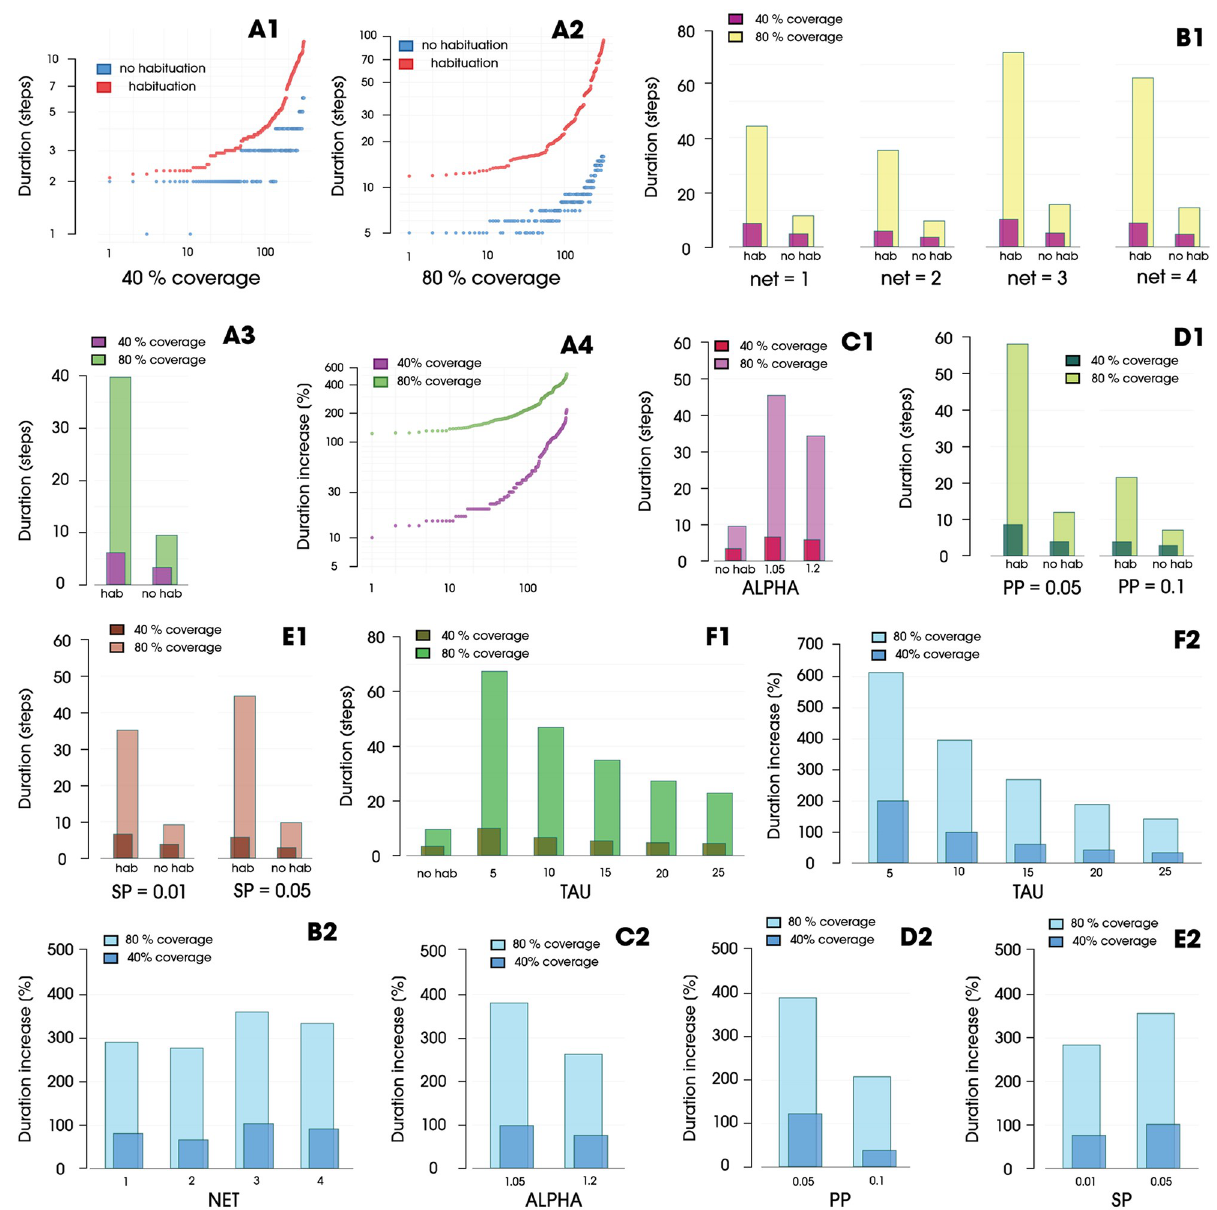
Fig 6. ( A1-A2 ) Distances between the durations of simulations with and without the habituation effect, with results sorted by duration without habituation and assigned corresponding results from processes with habituation. ( A3 ) Duration for spreading processes with and without habituation. ( A4 ) Duration increases in processes with the habituation effect, compared to processes without habituation, sorted by coverage increase. ( B1 ) Durations for each network for spreading processes with and without habituation. ( B2 ) Increases in duration for each network in relation to a process without habituation. ( C1 ) Durations for each alpha value for spreading processes with habituation compared to a process without habituation. ( C2 ) Increases in duration for each alpha value in relation to a process without habituation. ( D1 ) Durations for propagation probabilities for spreading processes with and without habituation. ( D2 ) Increases in duration for each PP in relation to a process without habituation. ( E1 ) Durations for each seeding percentage for spreading processes with and without habituation. ( E2 ) Increase in duration for each SP in relation to a process without habituation. ( F1 ) Durations for each tau value for spreading processes with habituation in comparison with processes without habituation. ( F2 ) Increases in duration for each tau value in relation to a process without